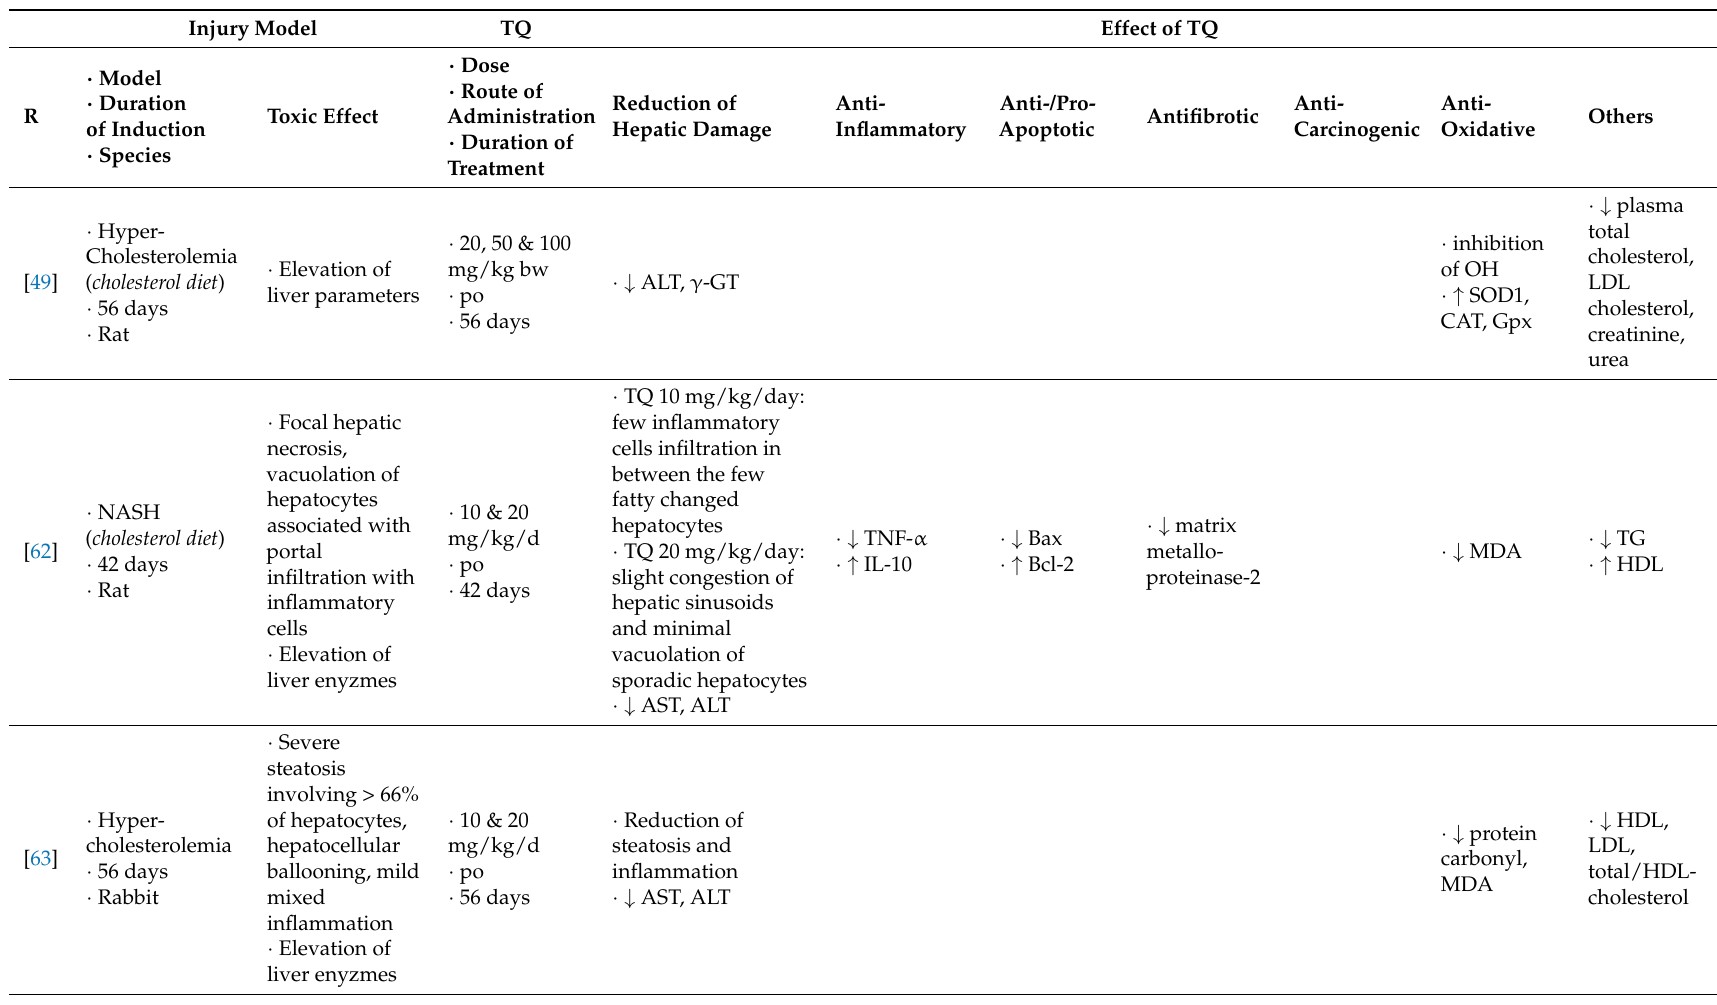
Table 5. Effects on liver injury caused by